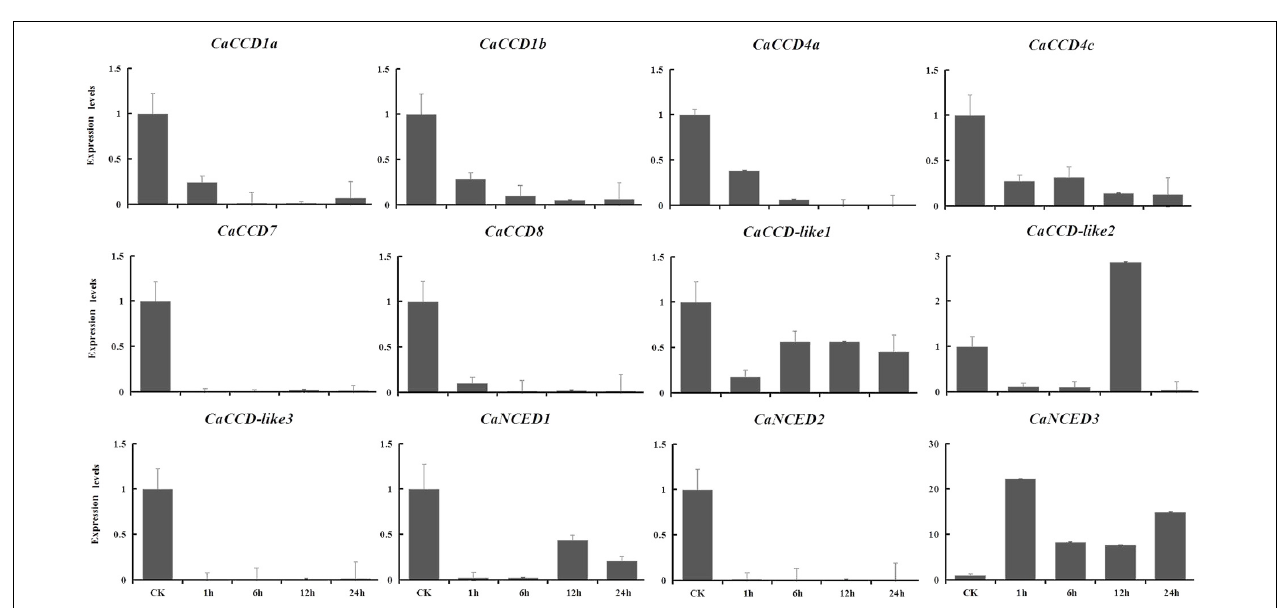
FIGURE 9 | Expression patterns of CaCCO genes in response to drought stress at different time points.